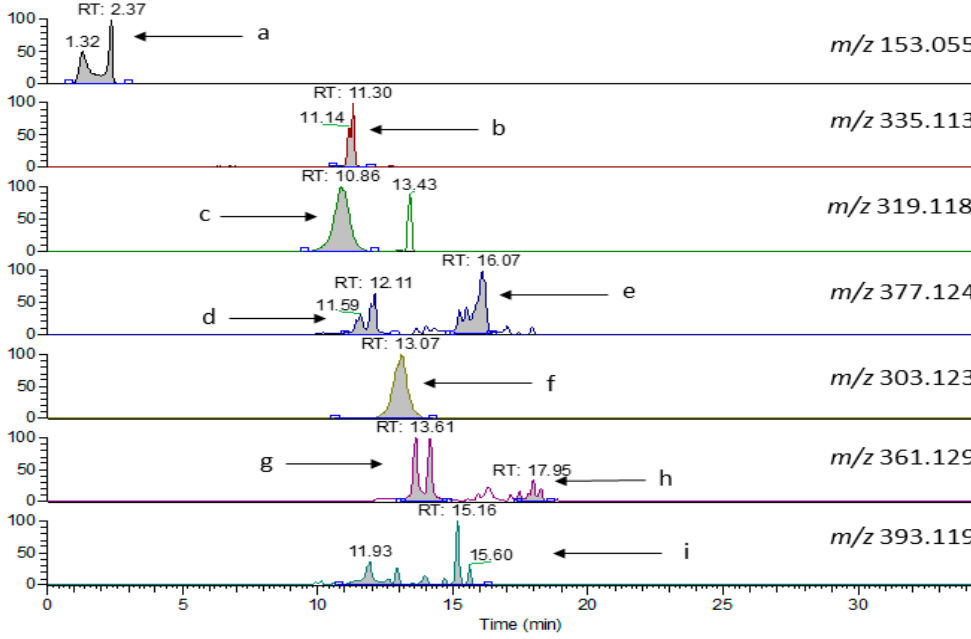
Figure 4. Extracted ion chromatograms in negative ionization mode (protocol E) for molecular ions of a: Htyr, b: Decarboxymethyl oleuropein aglycone oxidized dialdehyde form, c: Decarboxymethyl